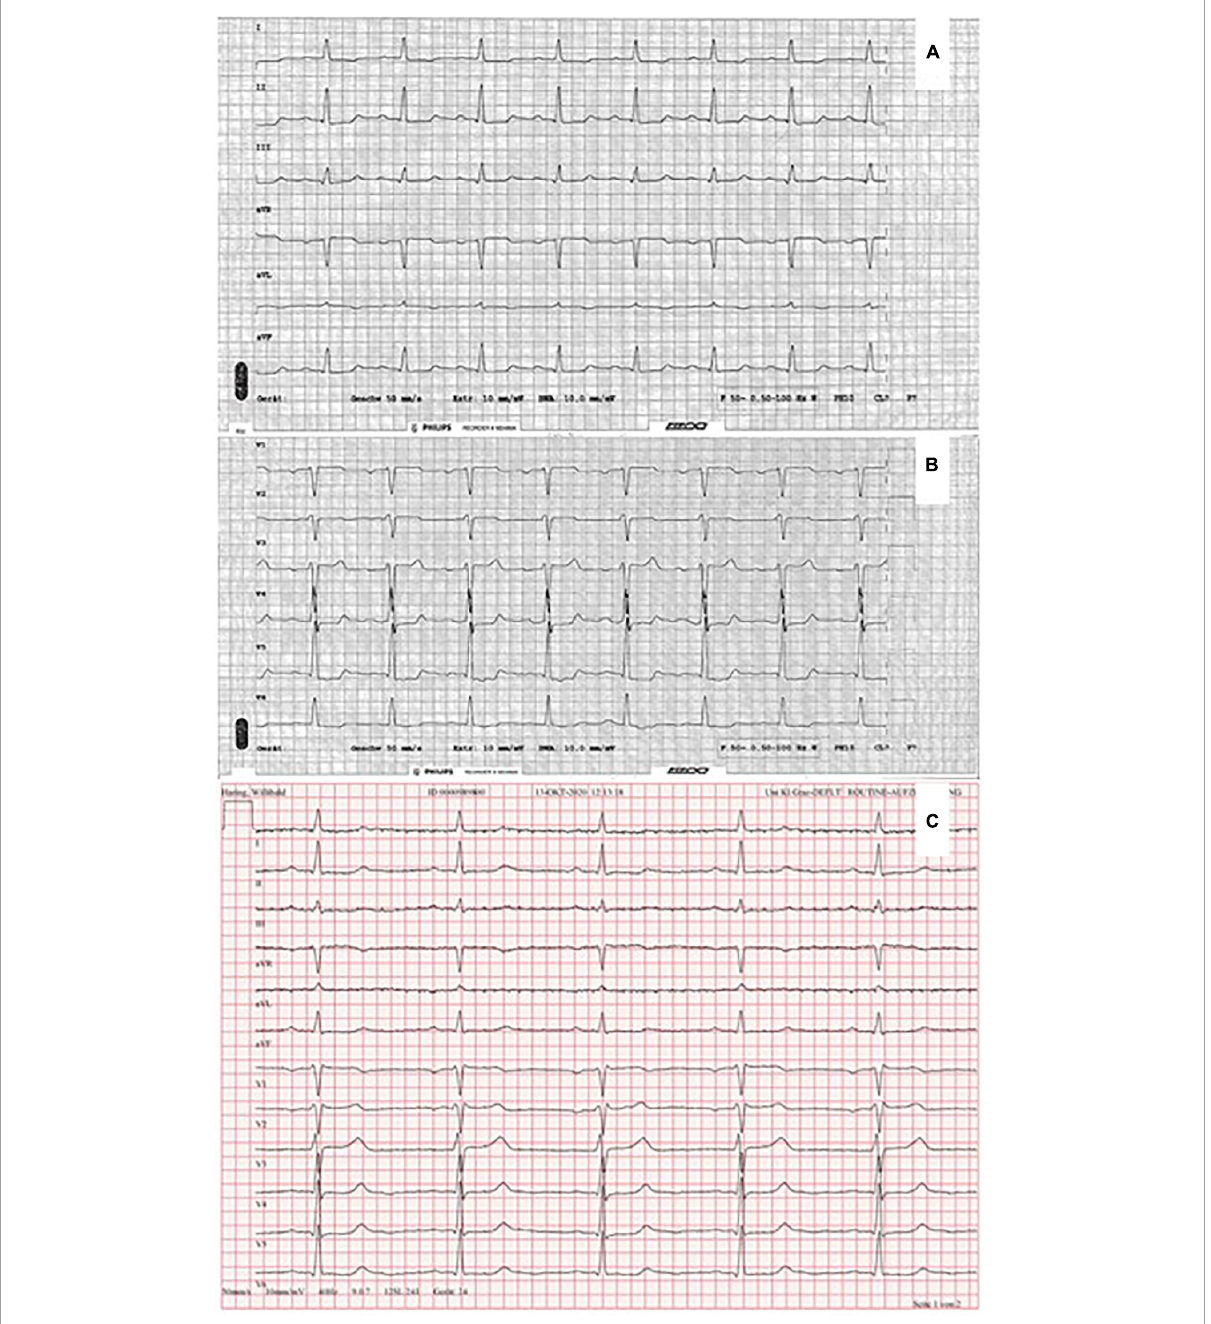
FIGURE2 Electrocardiogram showing ST-segment depression in II, III, aVF (A) , and V4–V6 (B) . Electrocardiogram (with a paper speed of 50 mm/s) 1 month before MINOCA (C)